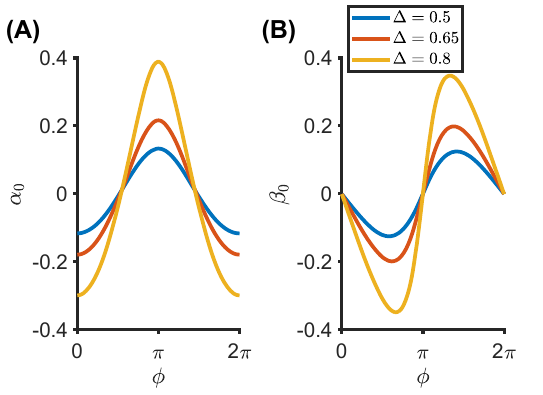
Figure 3: Nonlocal temporal boundary. (A) and (B) Nonlocal effective boundary parameters 𝛼 and 𝛽 , respectively, as a function of the 0 0 = 0, and a metamaterial with the modulation phase 𝜙 . Here, t 0 permittivity profile in Eq. (10) is considered with 𝜀 = 5.